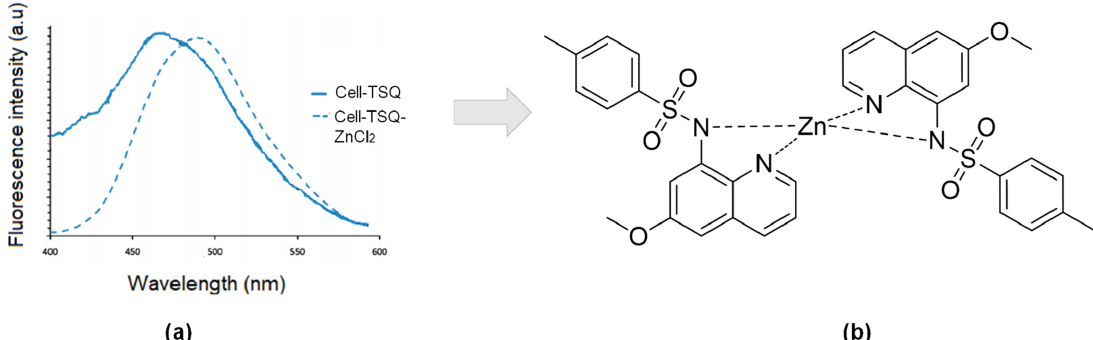
Figure 3. ( a ) Relative fluorescence of cells stained 30 min with 30 µ MTSQ (blue), then following addition of 30 µ M ZnCl 2 (dotted line). ( b ) Possible complexation of 6-methoxy-(8-p-toluenesulfonamido)quinoline (TSQ) 2 -Zn.